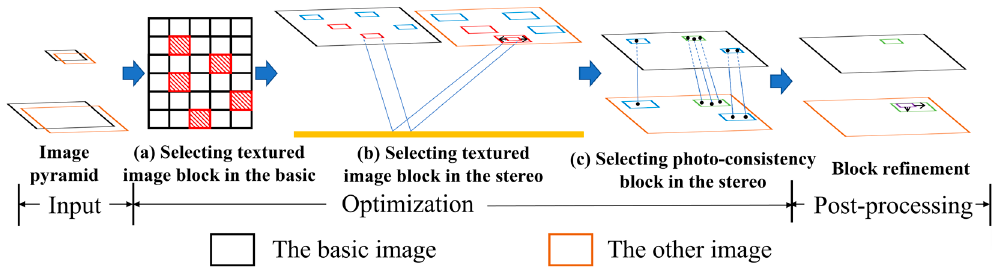
Figure 1. Workflow of the proposed method.